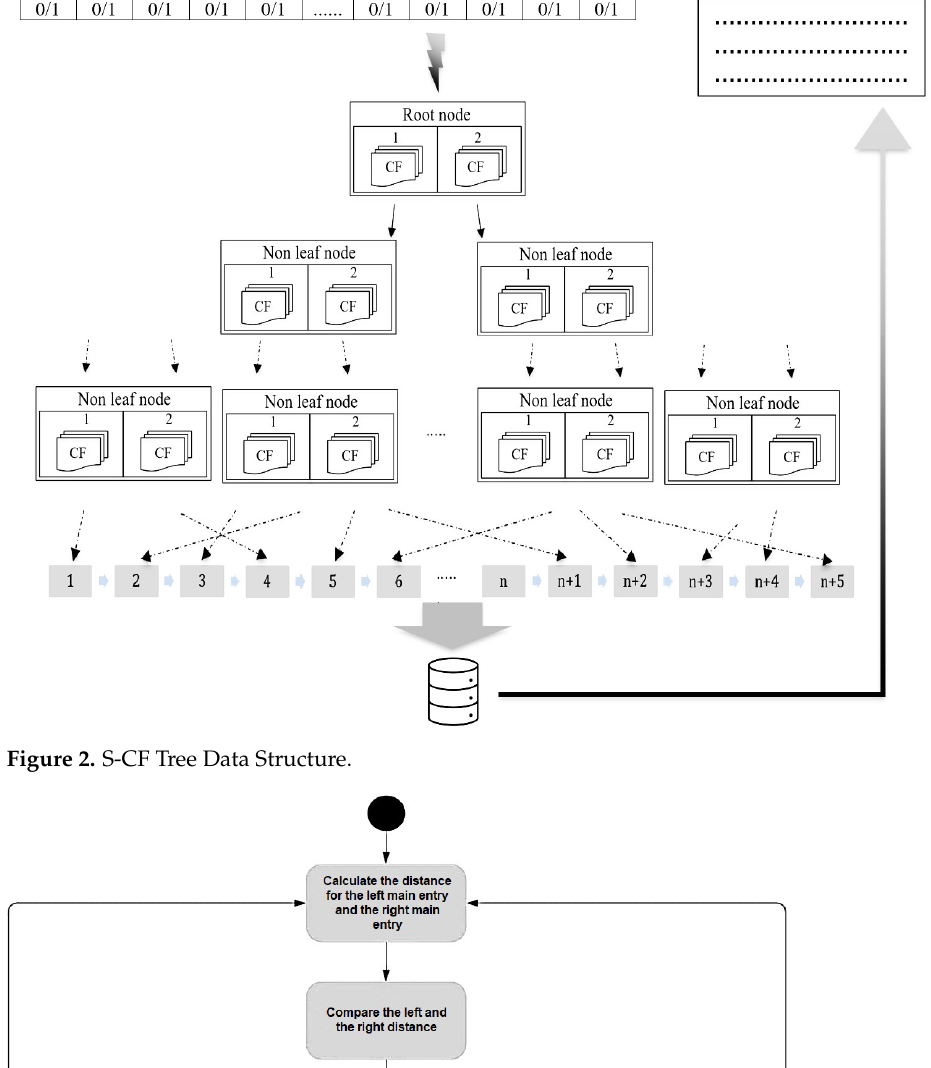
Figure 2. S-CF Tree Data Structure.